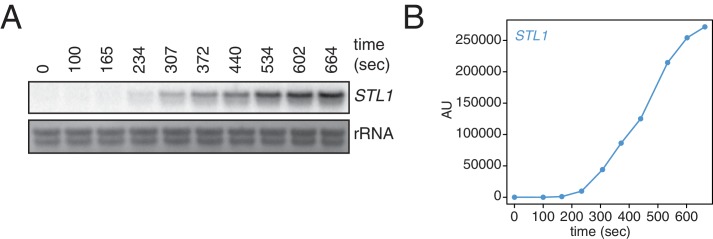
Kinetics of STL1 mRNA induction.(A) Wild-type cells (KWY165) were grown to exponential phase, subjected to a 0.4 M NaCl salt shock and samples were collected at the indicated times for northern blot analysis. (B) Quantification of data in (A). STL1 mRNA levels were corrected to background and also to rRNA levels.